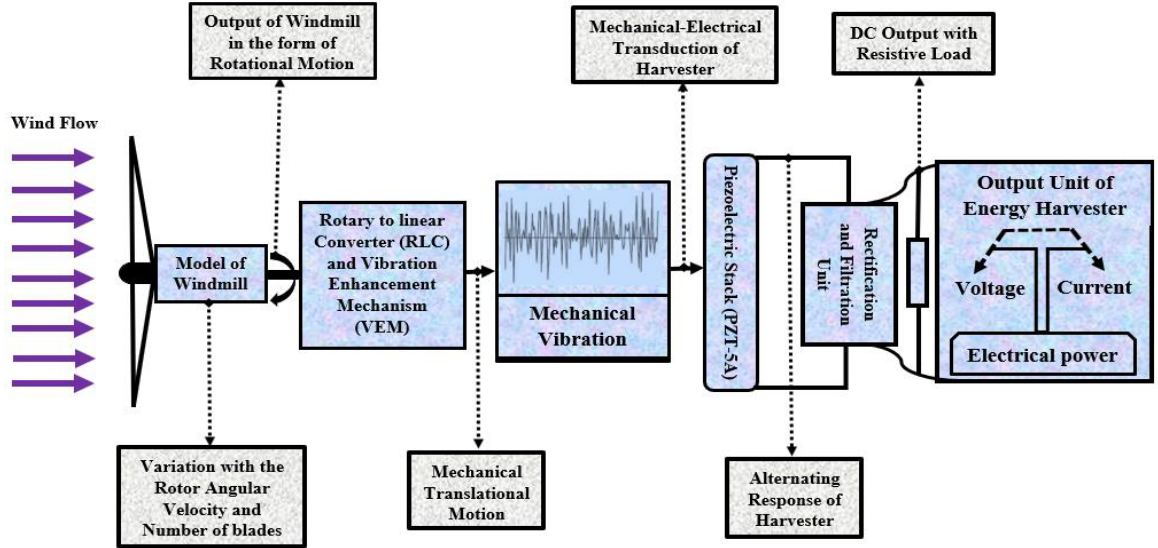
Figure 2. Schematic of the proposed piezoelectric wind energy harvester. Linear movement obtained from this mechanism depends upon the distance between the slider and slotted rod (Z), so, the endpoints of the slotted rod are linearly displaced by Z s as given in Equation (1).